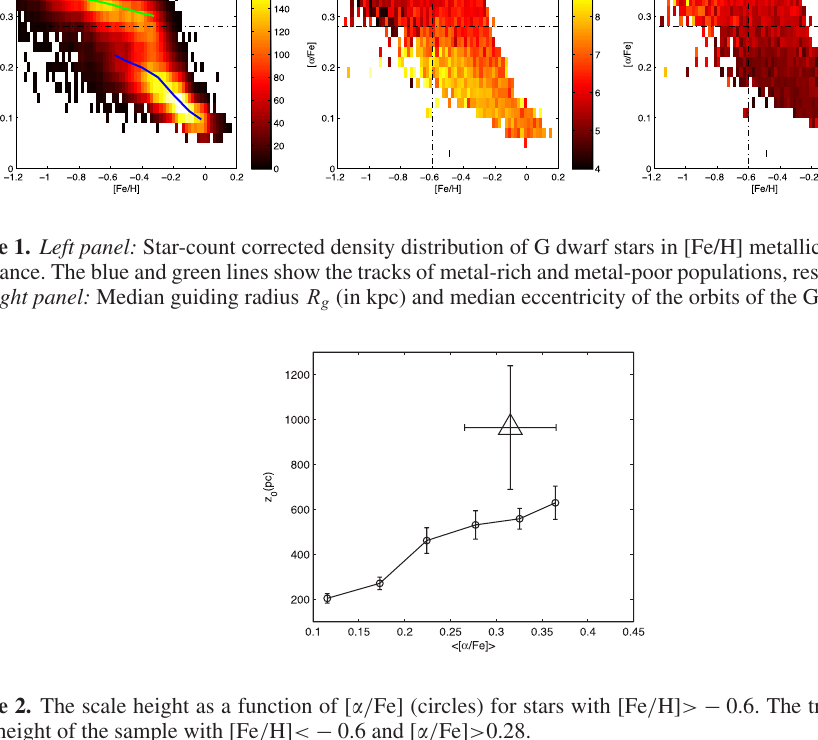
Figure 2. The scale height as a function of [ (cid:1) / Fe] (circles) for stars with [Fe / H] > − 0.6. The triangle shows the scale height of the sample with [Fe / H] < − 0.6 and [ (cid:1) / Fe] > 0.28. consistent with radial migration models [4, 7], in which metal-rich, old stars born at smaller radii have migrated toward the Solar Neighborhood while remaining on nearly circular orbits, but increasing their vertical height as they encountered a decreasing restoring